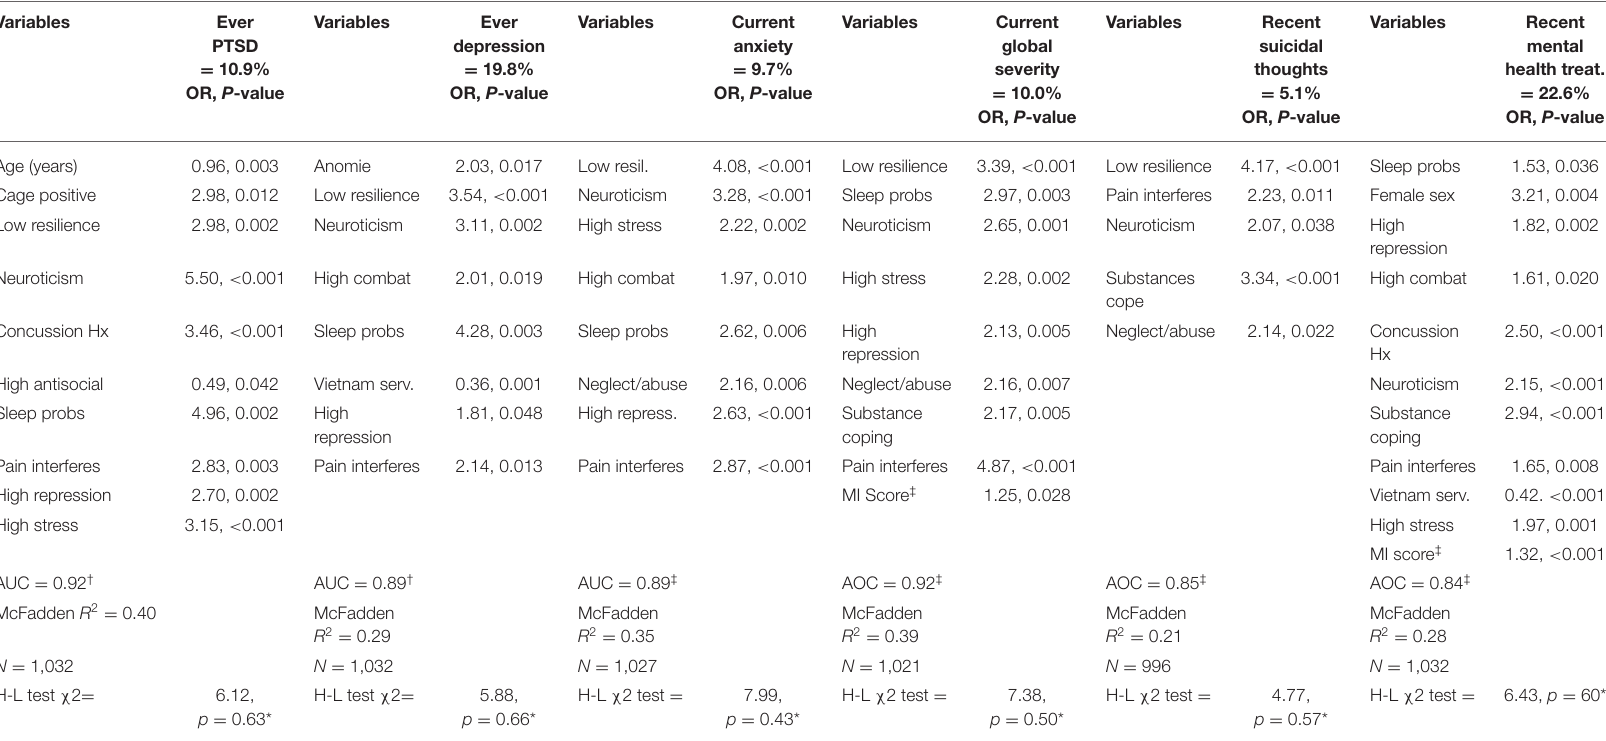
TABLE 3 | Multivariable logistic regression odds ratios and p -values predicting PTSD, depression, anxiety, global severity, suicidal thoughts, and mental Health treatment among veterans from selected neuro-psychosocial predictor variables.